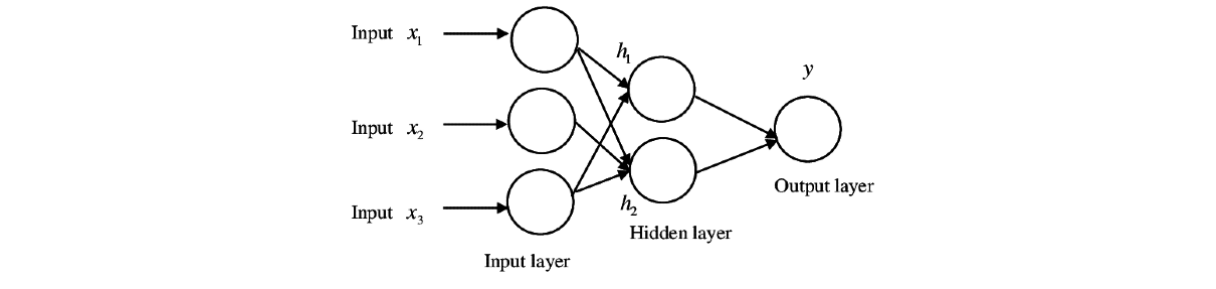
Figure 2. Schematic of a multilayer forward neural network.